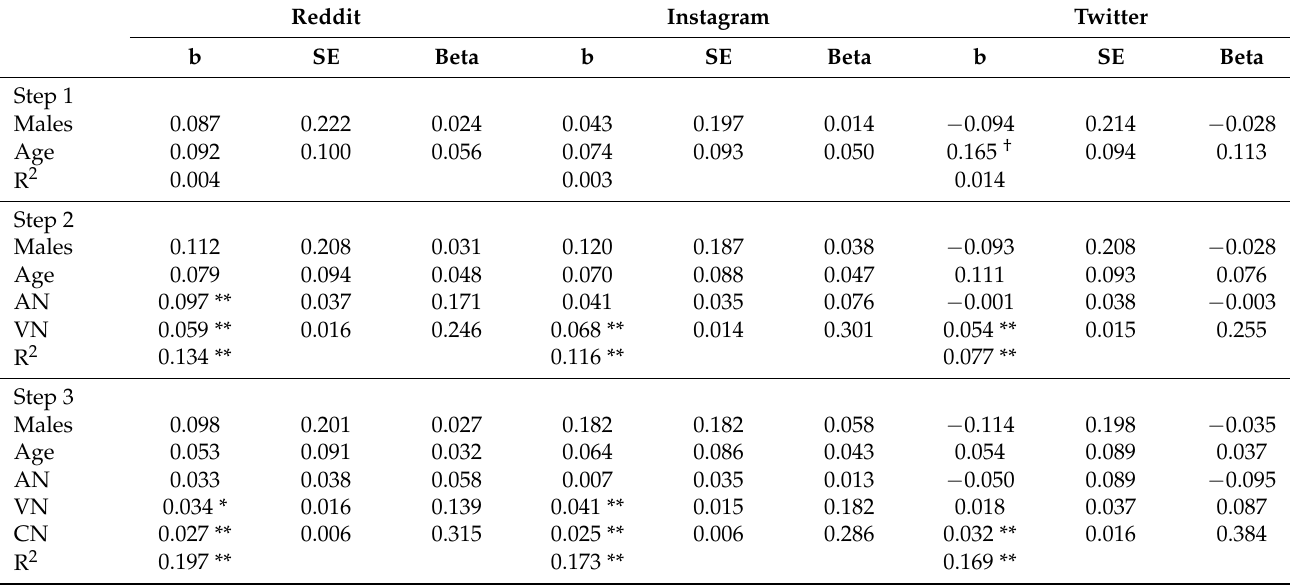
Table 6. Multiple linear regression predicting quality rating of social media for Reddit, Instagram and Twitter, showing unstandardized coefficients (b), standard errors (SE) and standardized coefficients (Beta).